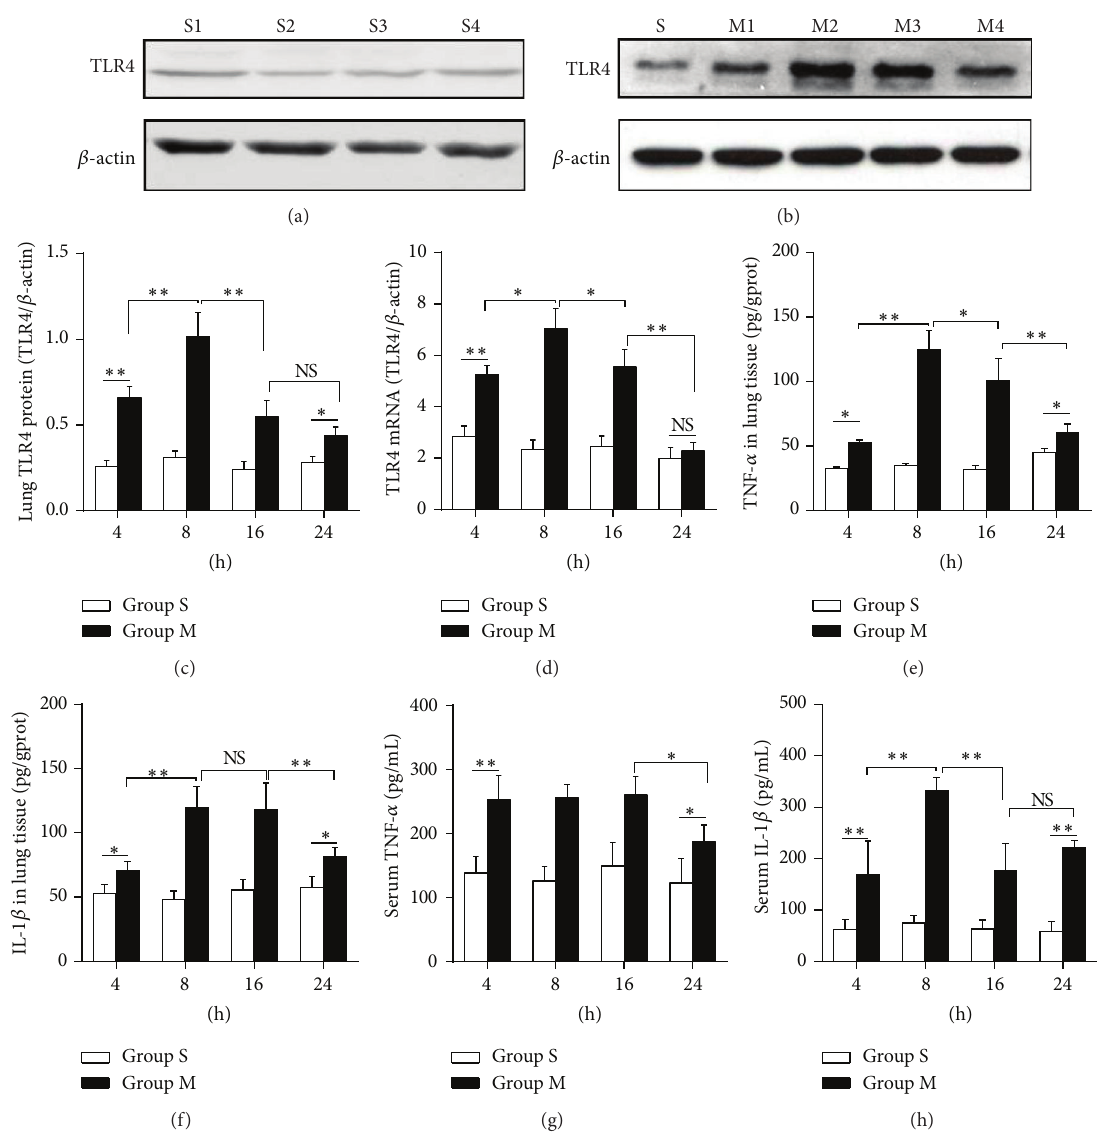
Figure 2: TLR4 gene and protein expression, concentration of TNF- 𝛼 and IL-1 𝛽 , and MPO activity in lung tissue or serum during OALT in a rat model. (a–c) TLR4 protein expression in lung tissue. (d) TLR4 mRNA expression in lung tissue. (e-f) TNF- 𝛼 , IL-1 𝛽 concentrations in lung tissue. (g-h) TNF- 𝛼 , IL-1 𝛽 concentrations in serum. Groups M1, M2, M3, and M4 represented as collecting samples at liver